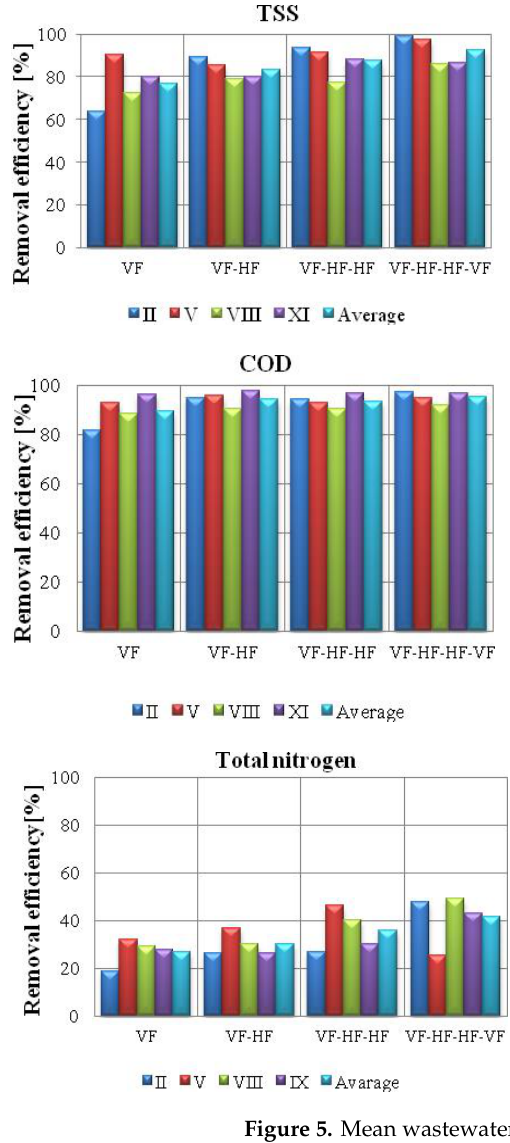
Figure 5. Mean wastewater treatment efficiencies by season.